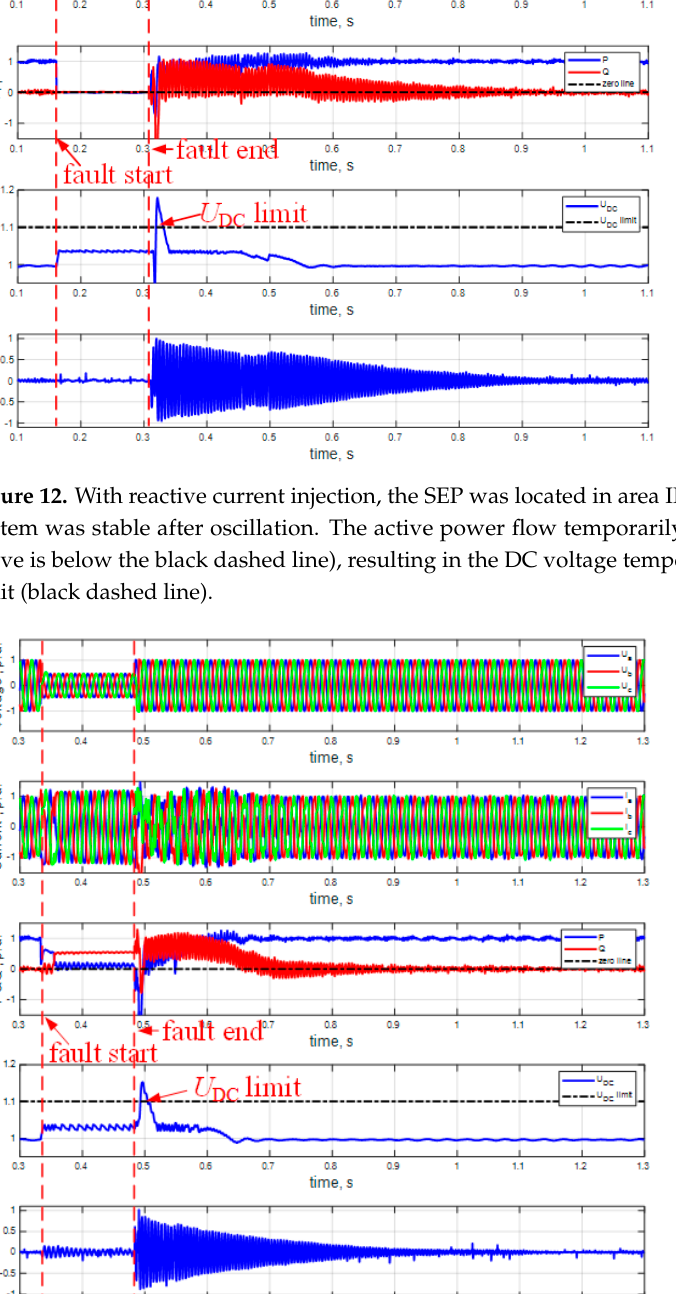
Figure 14. With reactive current injection, a reduction rate of * q I = 80 p.u./s, the faster reactive cur- rent exit rate caused a short-term reversal of active power (P curve below the black dashed line). Therefore, the DC voltage quickly returned to its nominal value after a fault.